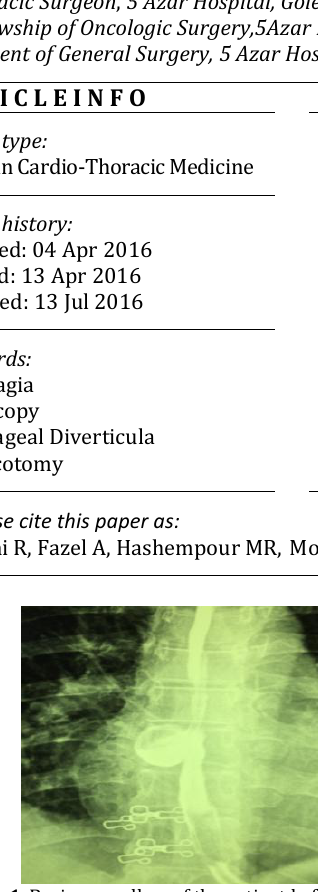
Figure 1. Barium swallow of the patient before surgery Figure 2. Endoscopic view of the esophageal diverticula with food impaction